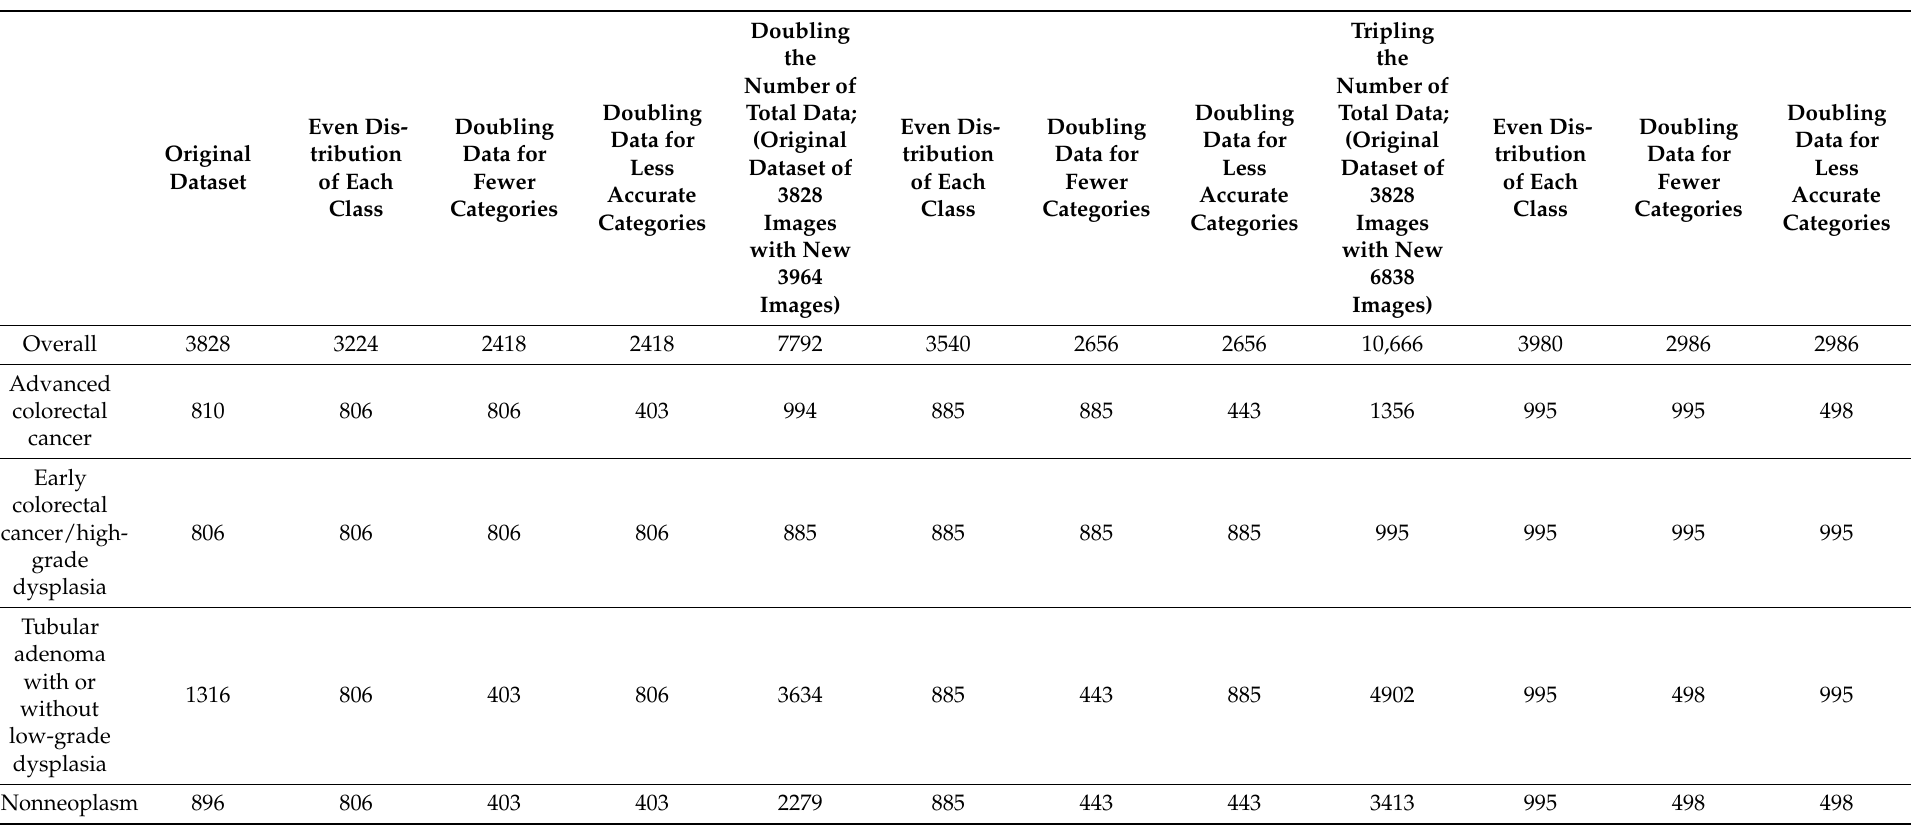
Table 1. Histological class distribution in input